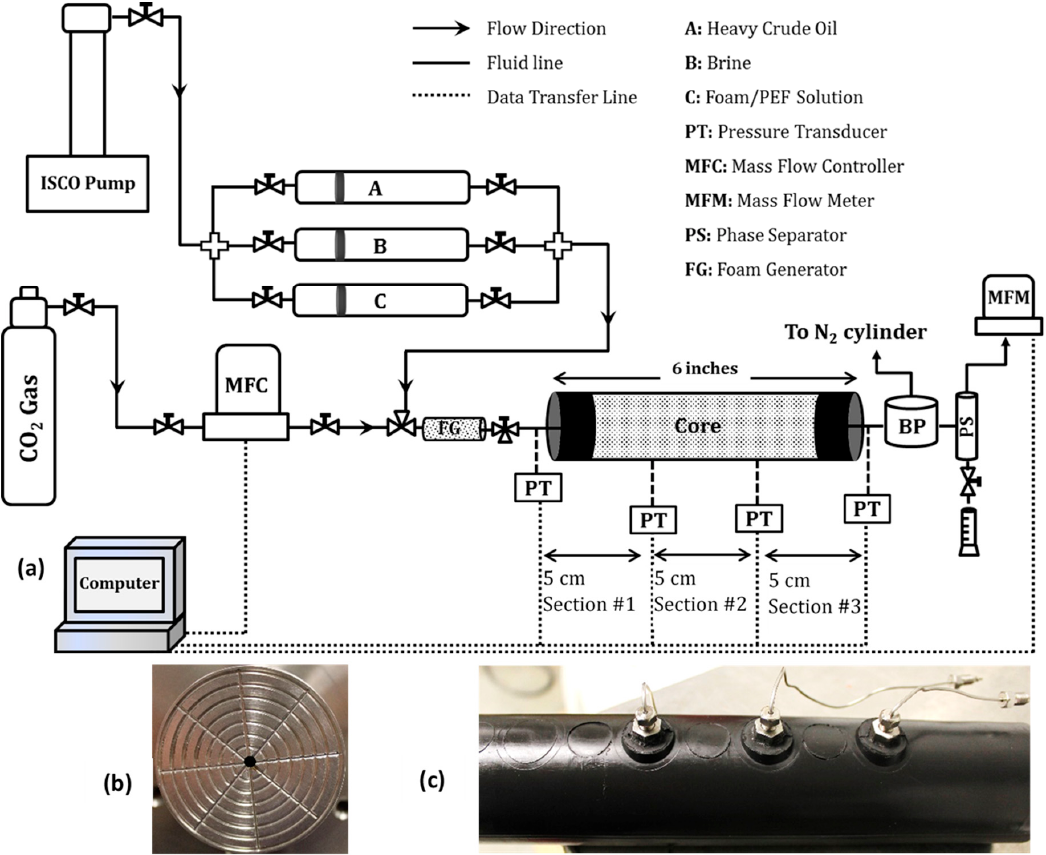
Figure 3. ( a ) Schematic of coreflood system used in this study, ( b ) image of the injection port, and ( c ) rubber sleeves with pressure taps for pressure measurement along the rock length. Table 1. Summary of rock properties and injection